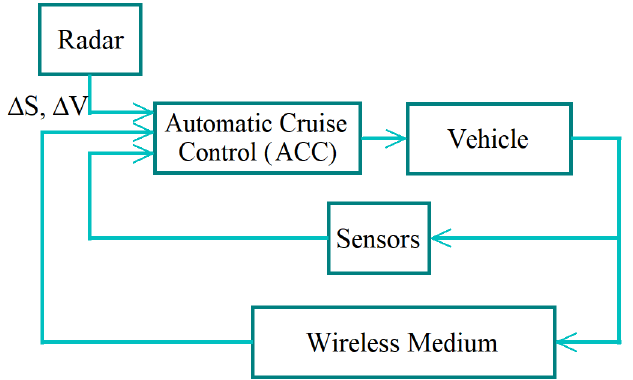
Figure 4. Adaptive cruise control (ACC) with vehicle [28].